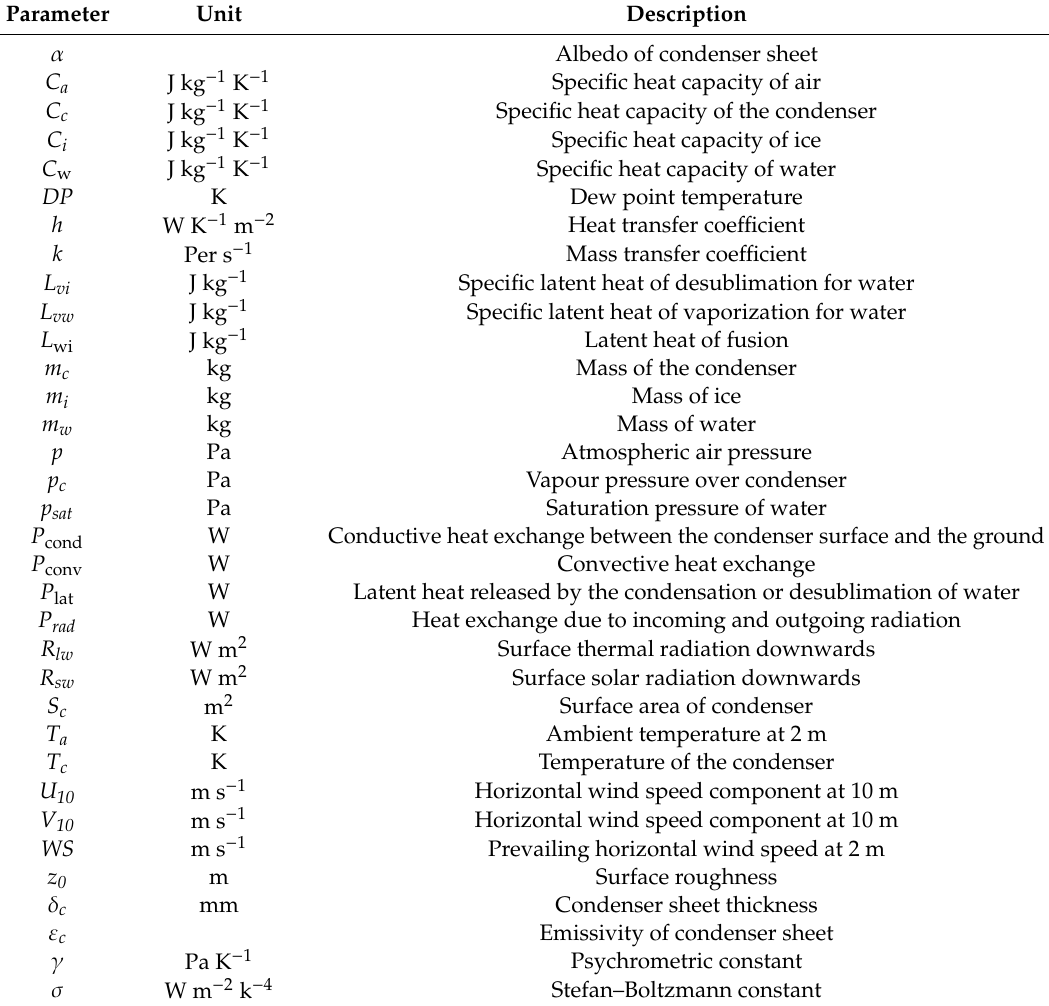
Table A2. A list of